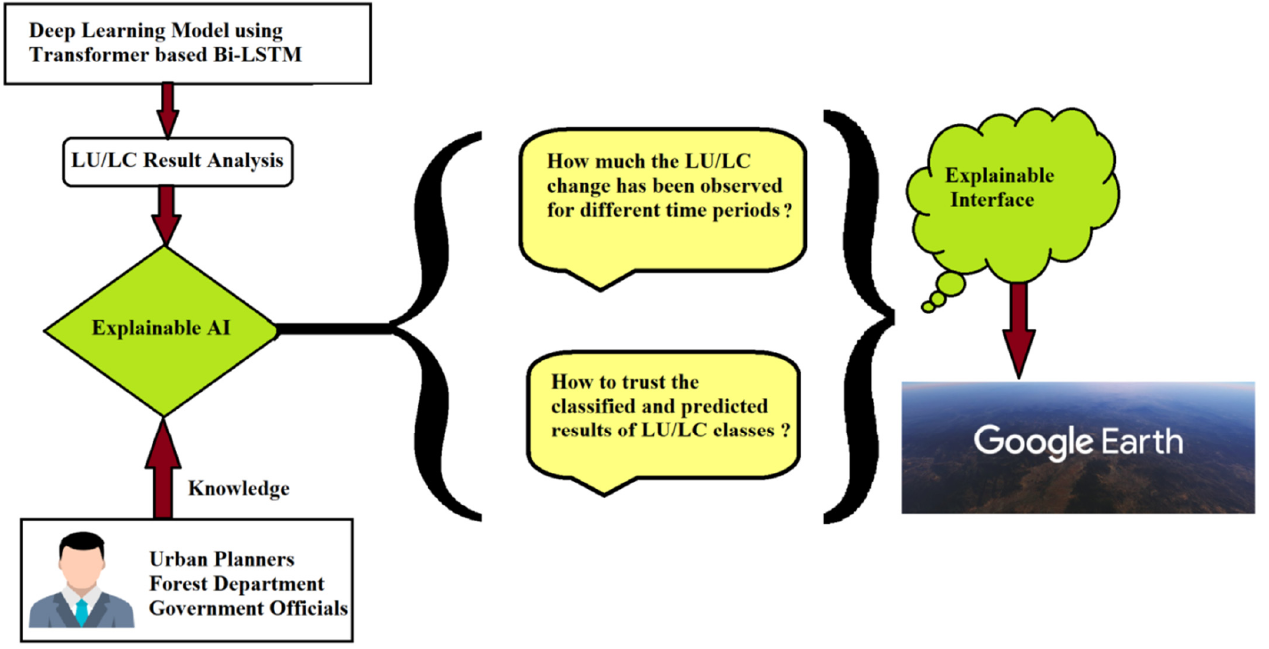
Figure 15. Explainable AI interface through Google Earth Engine platform.